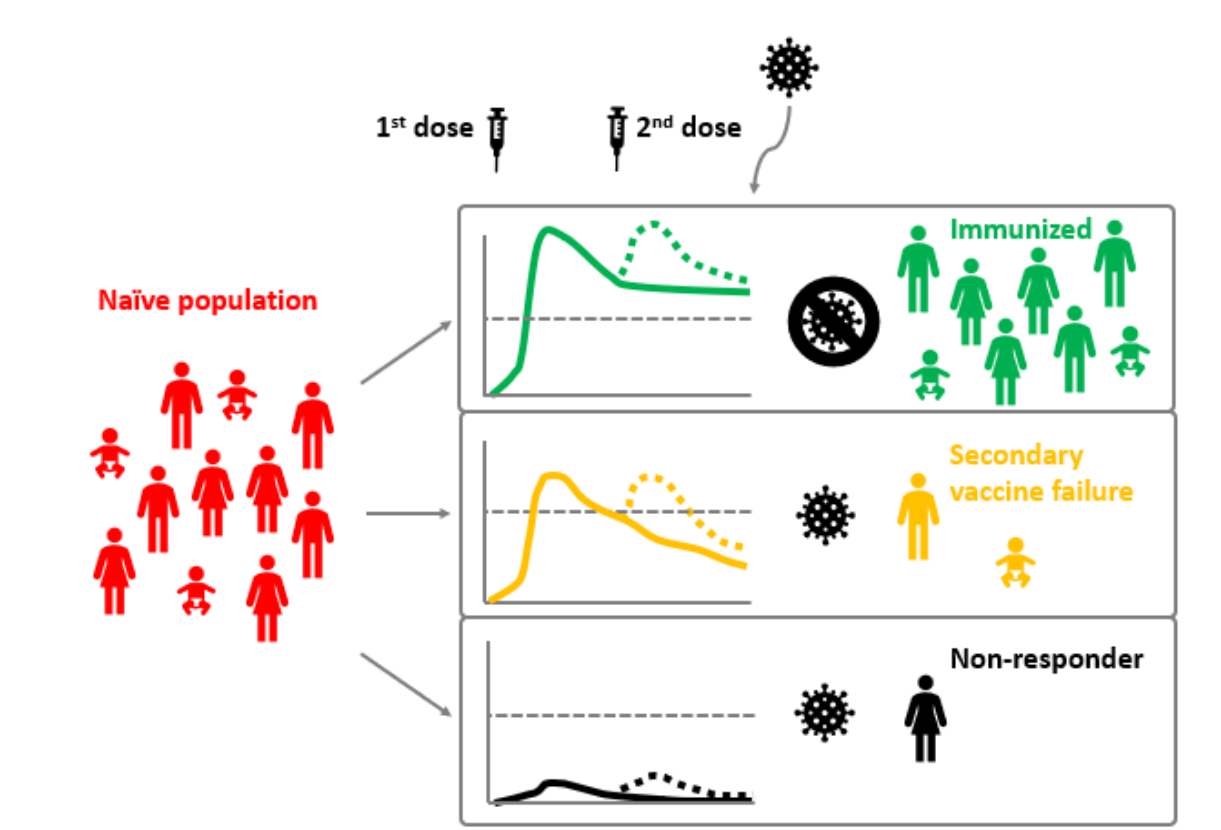
Figure 2. Possible vaccine outcomes in relation to type G immunoglobulins (IgG) levels. Immuniza- tion with a first vaccine dose causes the development of an immune response and the production of long-lasting levels of IgG (continuous lines) while a second vaccine dose causes a boost of IgG levels (dotted lines) that increases protection duration. Successfully immunized individuals maintain, already after the first dose, or develop after the second dose, an immunity that protects them from future infections and IgG levels are above the protective level (grey lines). Secondary vaccine failure occurs when the level of IgG drops below the protective level (although IgG can still be detected in these individuals), while non-responders are those subjects that never develop protective immunity (unmeasurable IgG levels).